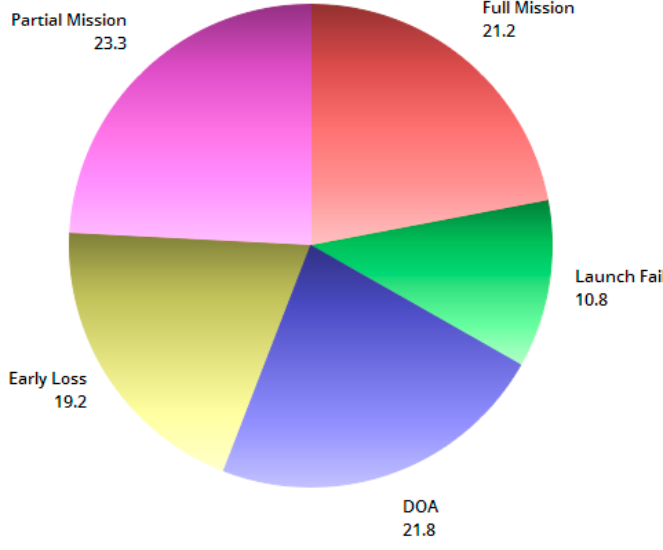
Figure 3. The CubeSat mission status from 1994 to 2017 (created based on [5]).